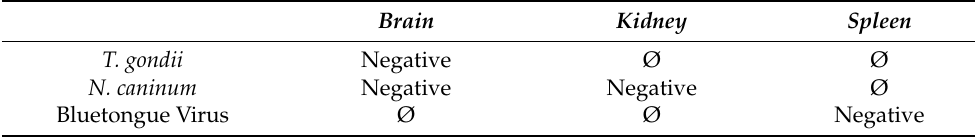
Table 5. Results of molecular testing of two lambs. Ø = Not tested.